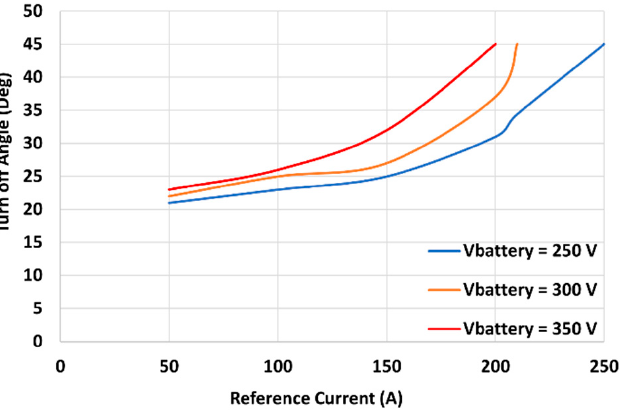
Figure 15. Output current response at (V battery = 250 V, θ on = 0°).